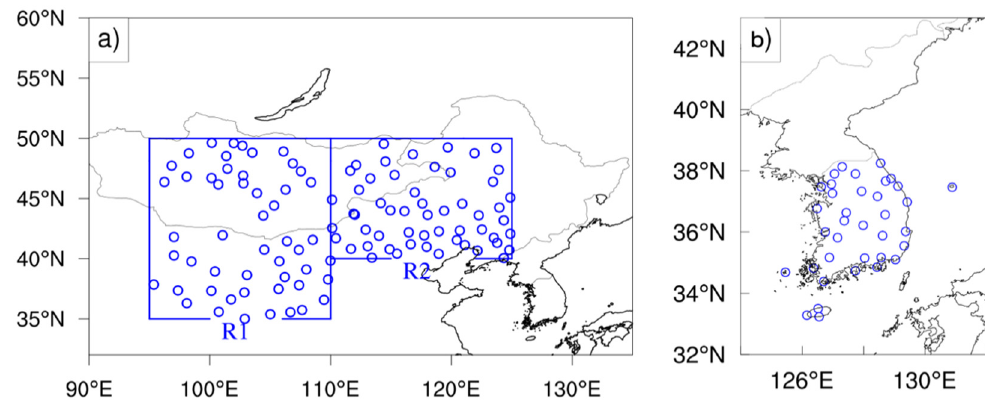
Figure 2. Locations of the SYNOP for calculating dust frequency; ( a ) 106 stations in the dust source regions and ( b ) 36 stations in South Korea.